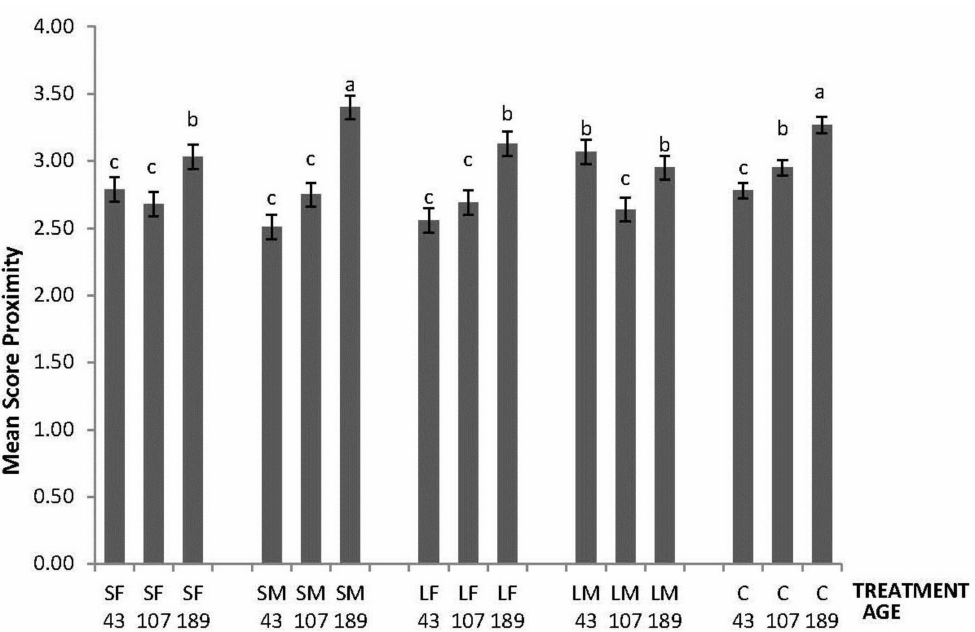
Figure 1. Novel Object test response depicted as Mean Score Proximity of 43, 107 and 189 days old layers from the control and four brooder treatments. Bars with no common letters differ significantly (mixed model ANOVA: p < 0.05). Treatments = SF: small fixed brooder; SM: small movable brooder; LF: large fixed brooder; LM: Large movable brooder; C: Control.